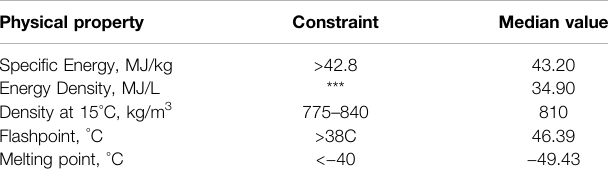
TABLE 1 | Jet-A constraints and Median Jet-A values for the physical properties considered in this work. Jet-A constraints come from ASTM D7566, and medianvaluescomefromthePetroleumQualityInformationSystem,andconsists of 770 data